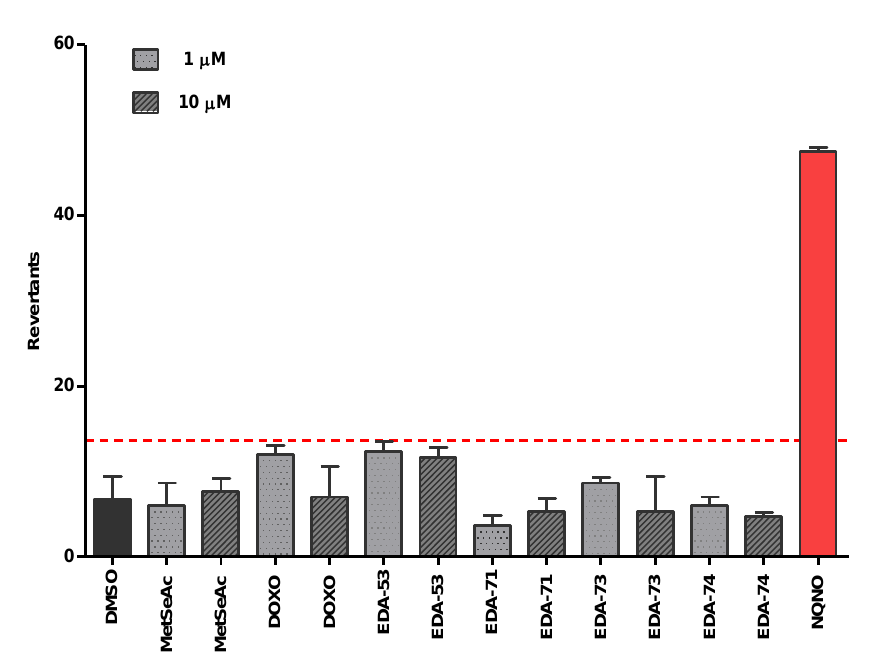
Figure 7. Safety profile (384 ‐ well microfluctuation Ames test) for the selenoesters with very high Figure 8. Safety profile (384-well microfluctuation Ames test) for the selenoesters with high cytostatic Figure 8. Safety profile (384-well microfluctuation Ames test) for the selenoesters with high cyto- cytostatic activity, DMSO—solvent control. All tested compounds and references were evaluated at activity. DMSO—solvent control. All tested compounds and references were evaluated at 1 and static activity. DMSO — solvent control. All tested compounds and references were evaluated at 1 Bolded B values indicate risk of cytotoxic or mutagenic effects (see footnote of Table 3 for full de- 1 and 10 μ M concentrations, except for NQNO (0,5 μ M); ‐‐‐‐ baseline defining the mutagenicity 10 µ M concentrations, except for NQNO (0,5 µ M); baseline defining the mutagenicity threshold and 10 µM concentrations, except for NQNO (0,5 µM); ---- baseline defining the mutagenicity scription). Bolded MI value denotes mutagenicity. threshold (over this line). (over this line). threshold (over this line).